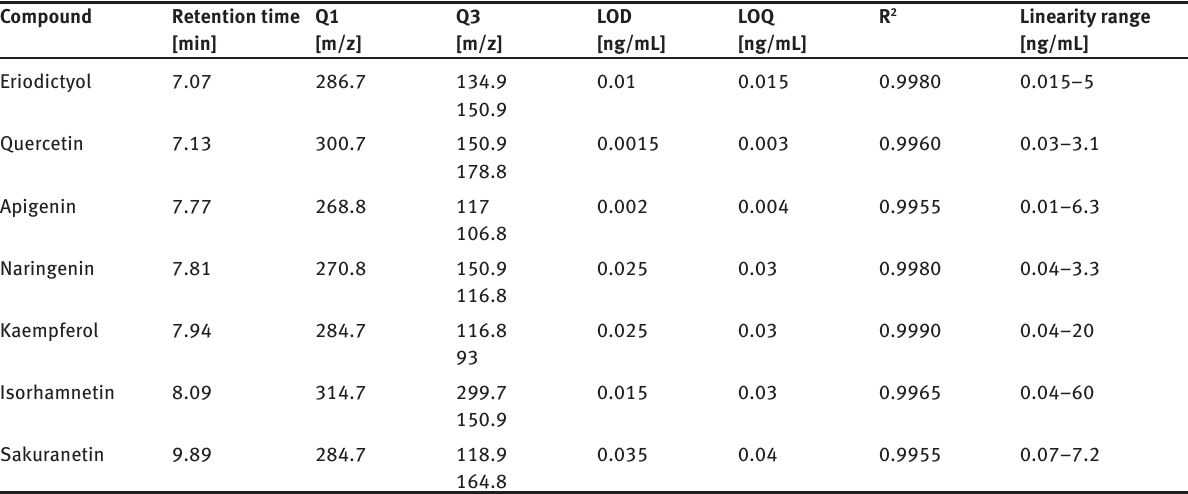
Table 4: Summary of optimized parameters for quantitative analysis of flavonoid aglycones. Compound Retention